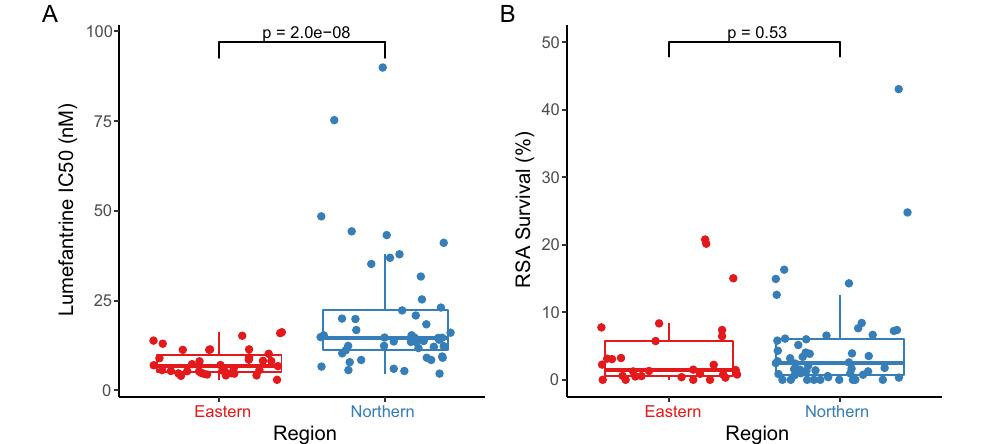
boxescorrespond to themedian,and minimaland maximalboundscorrespondto 25th and 75th percentiles, respectively. Whiskers extend to extreme values no further than 1.5x the IQR from the 25th or 75th percentiles. Source data are pro- vided as a Source Data fi le.